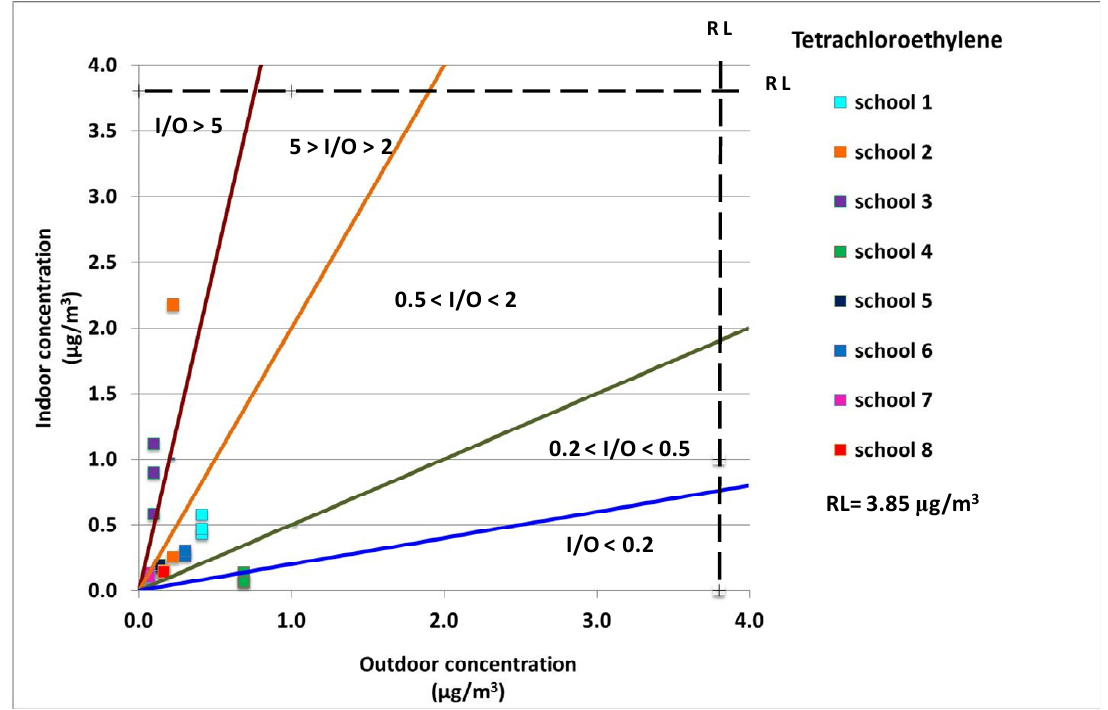
Figure 2. Tetrachloroethylene indoor concentrations against outdoor concentrations in all monitored sites. The reference level (RL) and five different I/O ranges were also